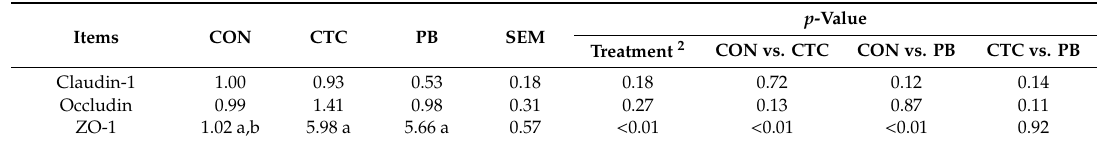
Table 8. E ff ects of probiotics on gene expression levels of claudin-1, occludin and ZO-1 genes in the jejunum barrier function of broilers (day 42) 1